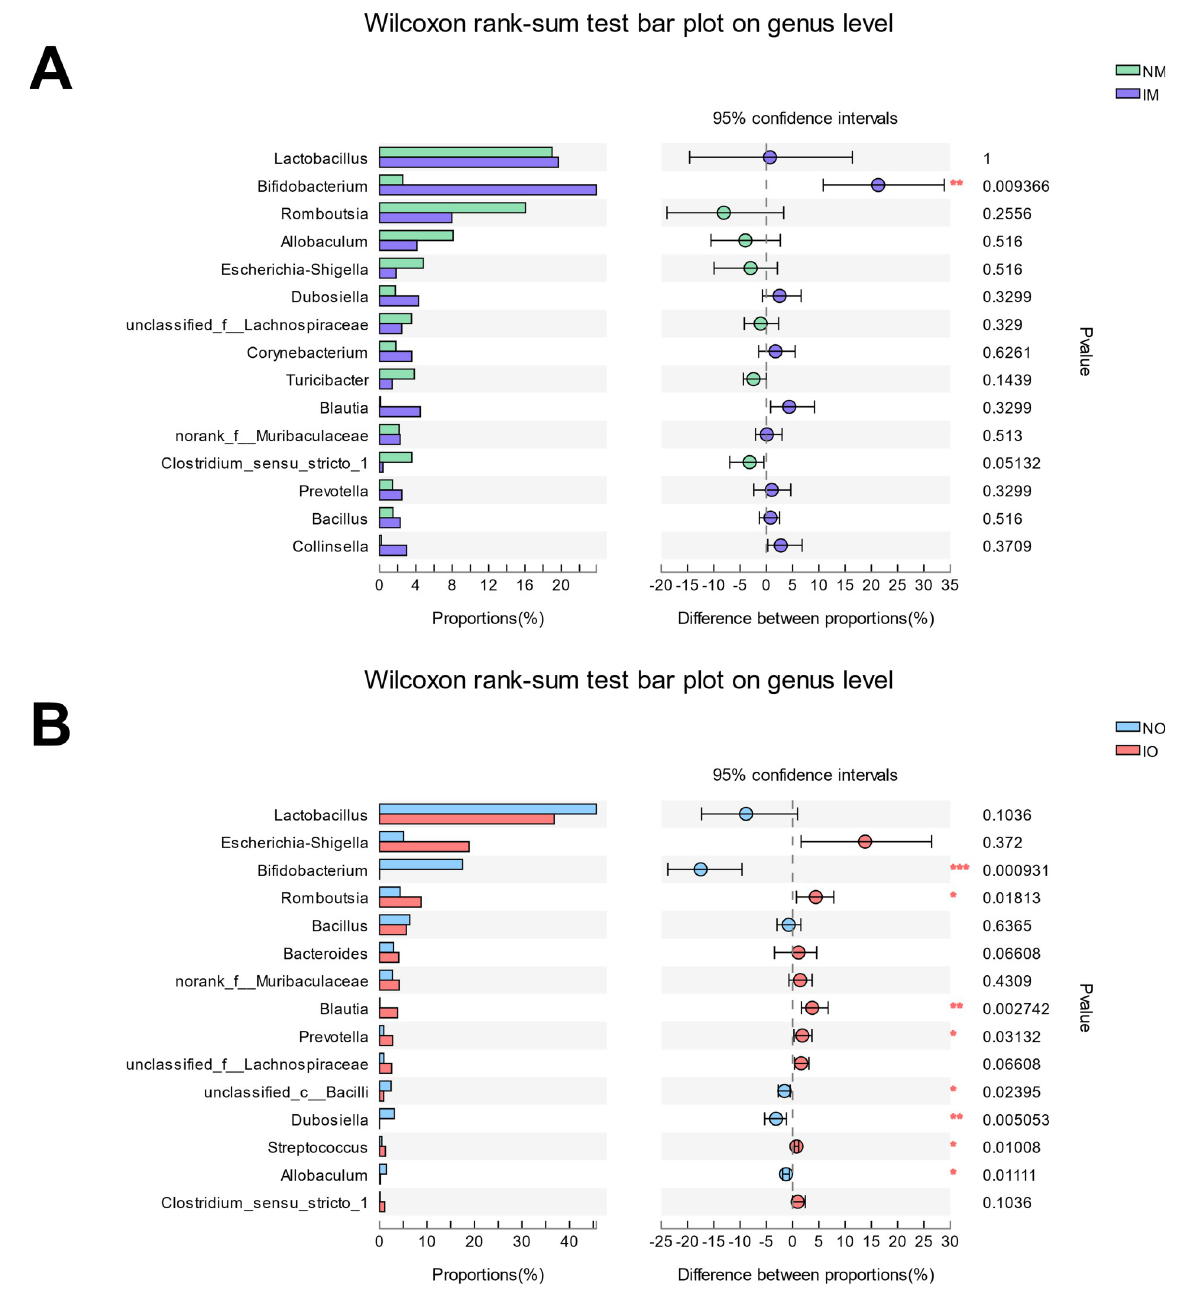
Fig 6. Analysis on the significantly different species at genus level. (A) Analysis on the significantly different species in maternal group; (B) Analysis on the significantly different species in offspring ( * , p < 0.05; ** , p < 0 .01; *** , p < 0 .001). that the adult offspring born to those pregnant rats that were fed with high-fiber feeding were imparted with robust resistance against severe allergic airways disease, which might be attrib- uted to the production of short-chain fatty acids in the maternal intestine [29, 30]. In this study, pregnant rats in inulin group during gestation was fed with the aqueous solution con- taining 10% inulin; then the consequence of maternal inulin intake on lung inflammation was explored through the modeled asthma offspring from NM group and IM group. Results of